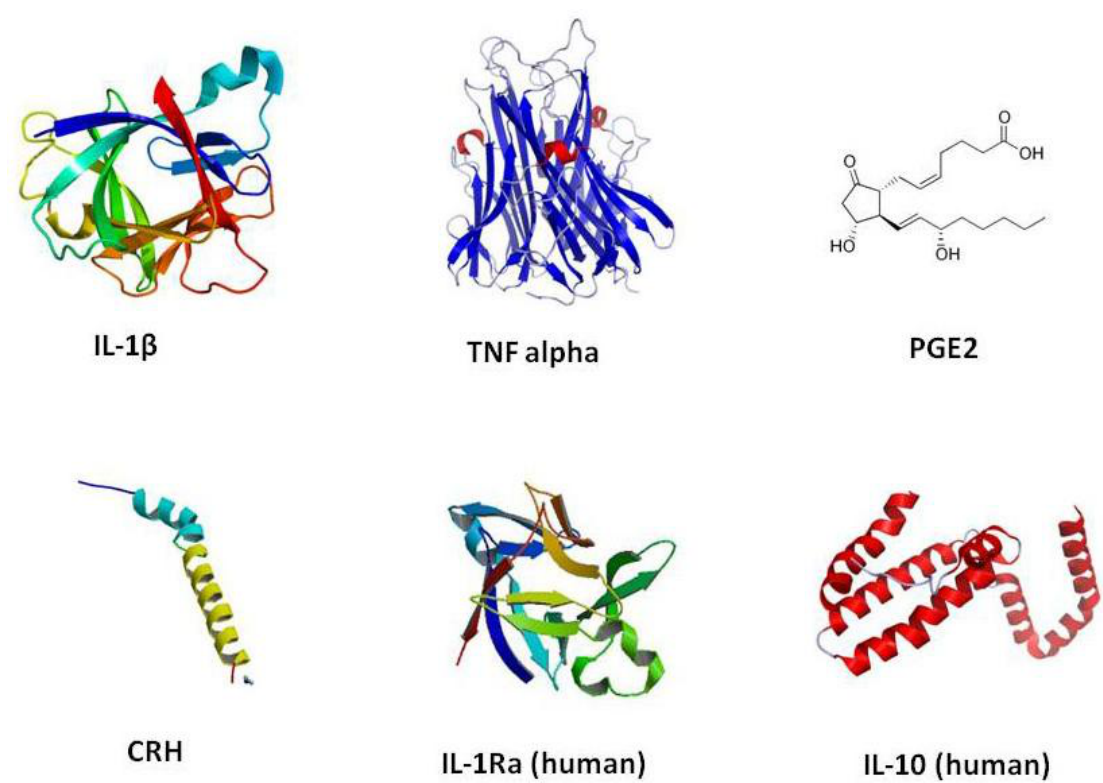
FIGURE 3. Endogenous pyrogens and antipyretics. Molecular structure of endogenous pyrogens IL-1β, TNF, prostaglandin E2 (PGE2), corticotropin releasing hormone (CRH), and two endogenous antipyretics involved in the termination of the fever response, the IL-1 receptor antagonist (IL-1RA) and IL-10. All structures were obtained from PDB (http://www.rcsb.org) and rendered using Pymol